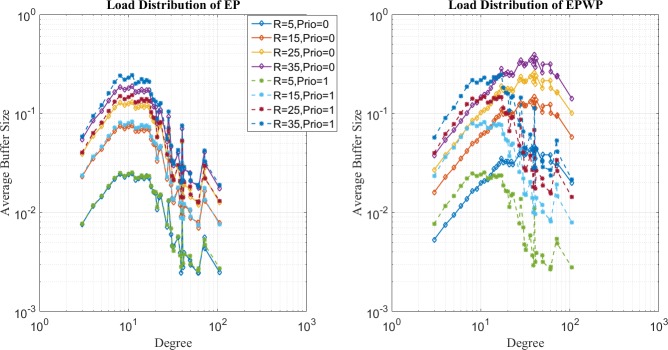
Relationship between average buffer size of two strategies and node degree for EP (left figure) and EPWP with β1 = 0.5 (right figure) on networks with 500 nodes.